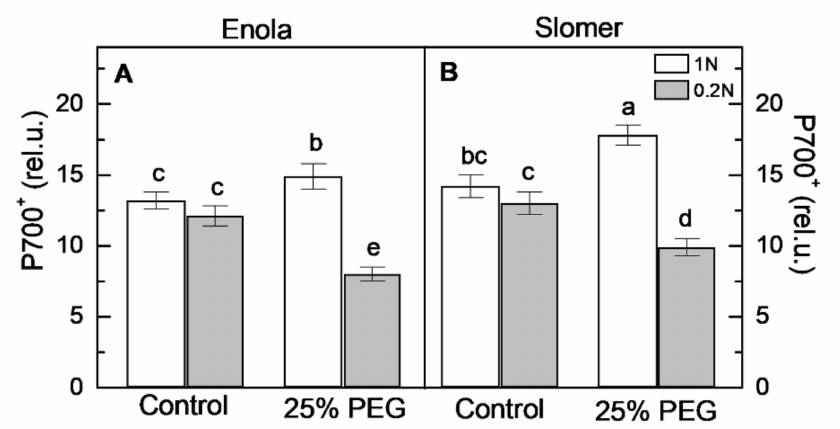
Figure 9. Photooxidation of P700 (P700 + ) measuring as ∆ A 830 in leaves of two wheat varieties (Enola and Slomer) grown with two nitrogen supply levels (1 N and 0.2 N) and subjected to osmotic stress with 25% PEG. Different letters represent significant differences at p < 0.05 ( n =